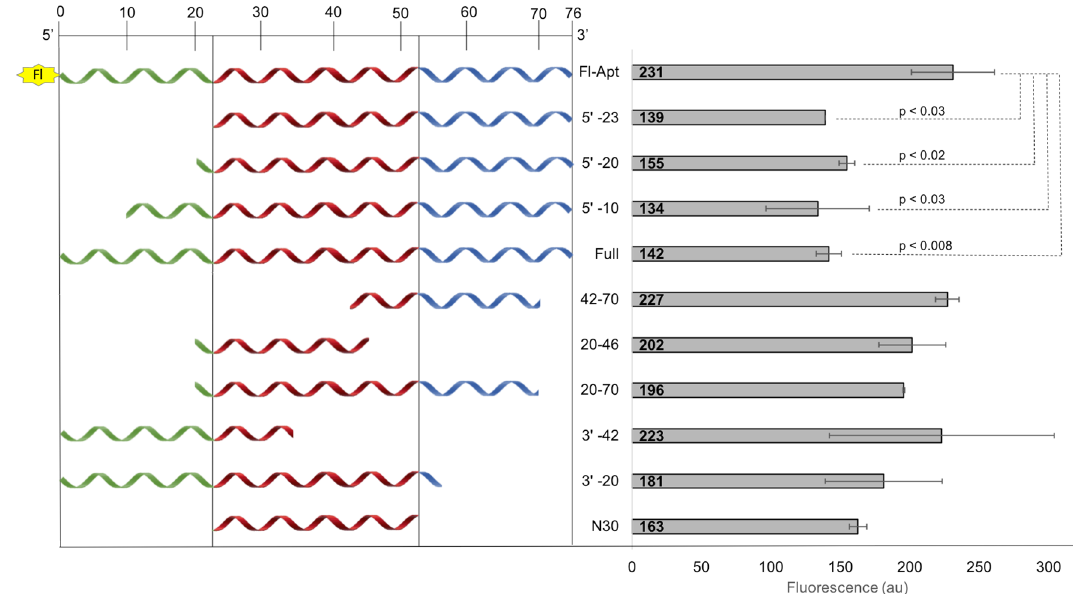
Figure 6. Truncation of KGE02 aptamer. Relative sequence length (left) and average fluorescence (right) of fluorescein-labeled full length KGE02, unlabeled full length KGE02, and nine unlabeled truncated